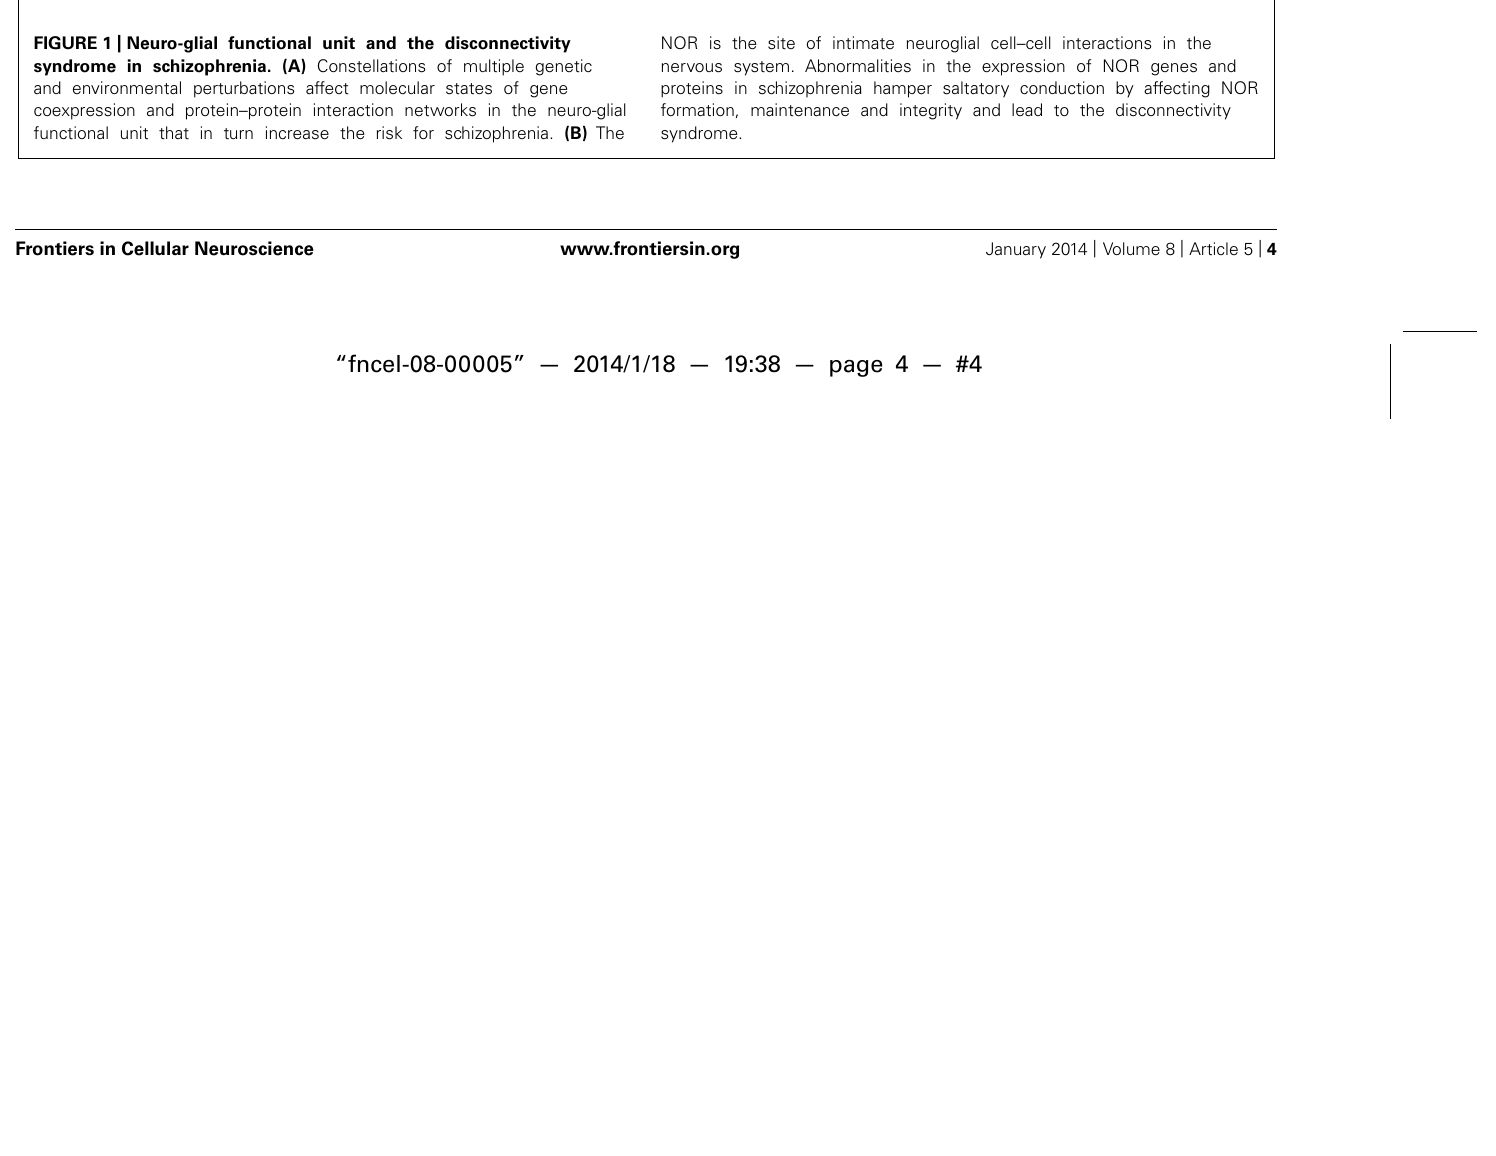
FIGURE 1 | Neuro-glial functional unit and the disconnectivity syndrome in schizophrenia. (A) Constellations of multiple genetic and environmental perturbations affect molecular states of gene coexpression and protein–protein interaction networks in the neuro-glial functional unit that in turn increase the risk for schizophrenia. (B) The